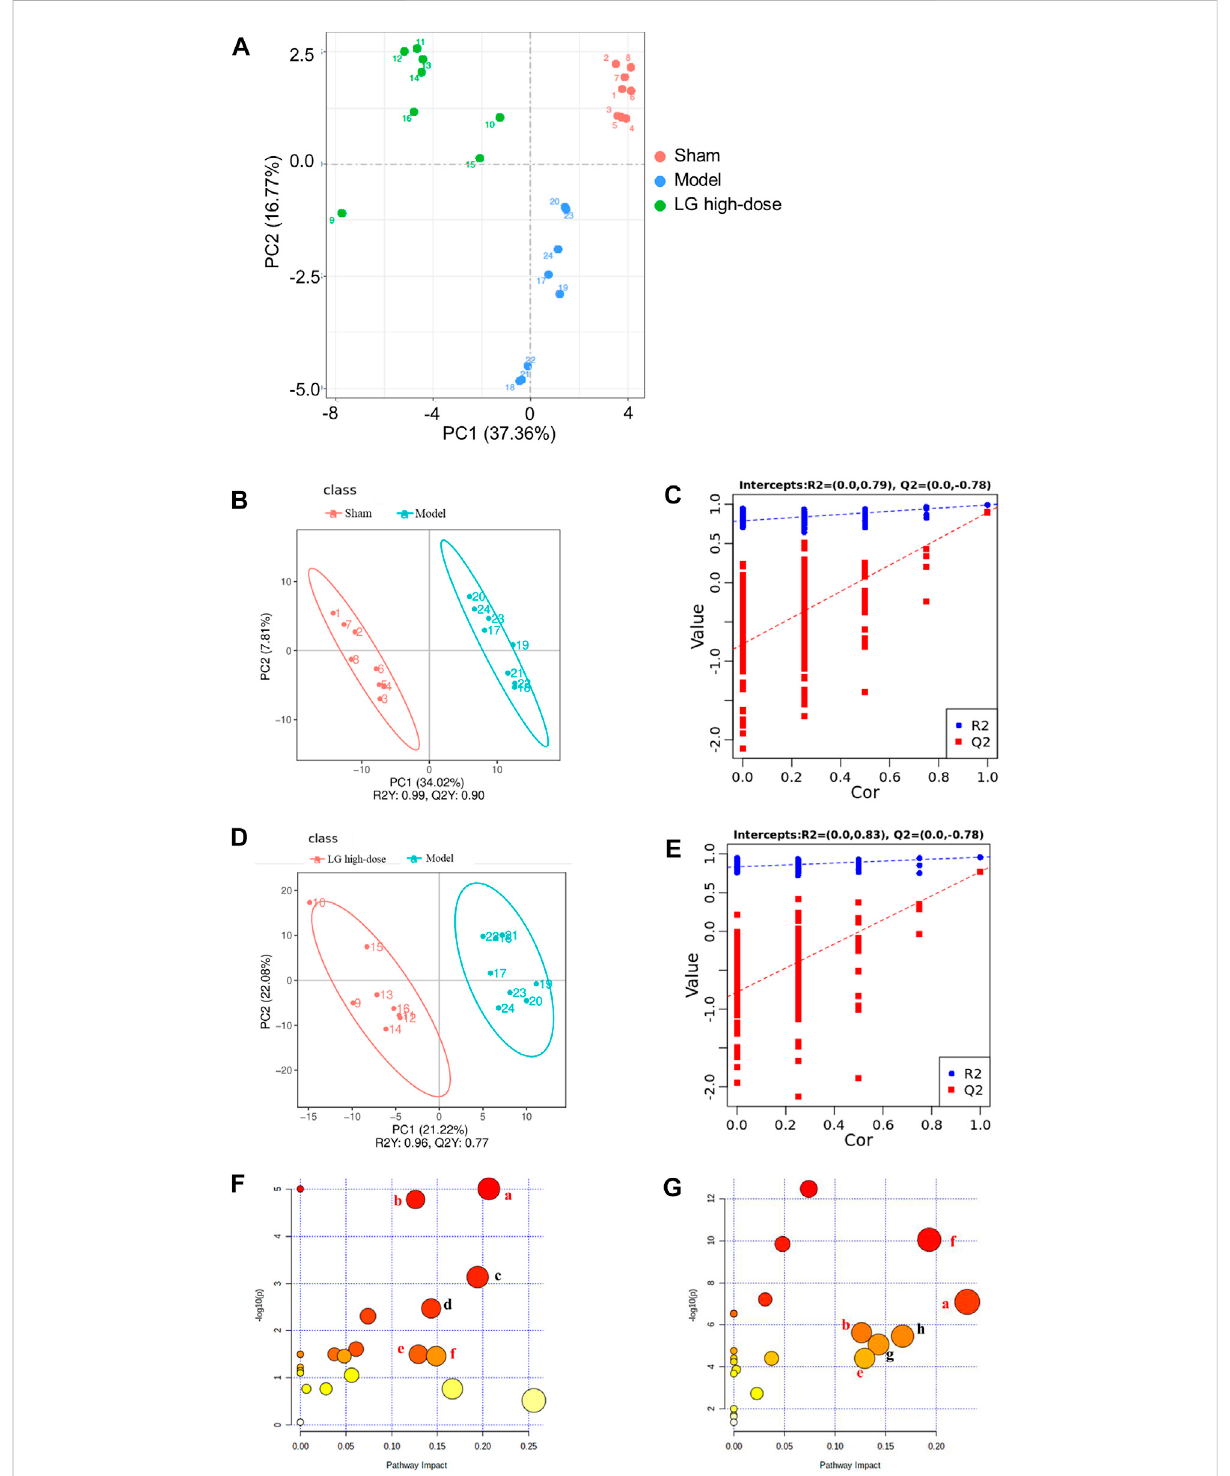
FIGURE 4 LG treatment modulated the metabolites in lung in sepsis-associated lung injury model rats. (A) Scores plots of PCA among each group. (B,C) Scores plots of PLS-DA between the sham and model groups and the corresponding coef fi cient of loading plots. (D,E) Scores plots of PLS-DA between themodel and LGhigh-dosegroups and the corresponding coef fi cient of loading plots. (F,G) Summaryof pathway analysis betweensham and model groups (F) and between model and LG high-dose groups (G) , the common pathways have been marked in red. (A) Glycine, serine and threonine metabolism; (B) Cysteine and methionine metabolism; (C) Nicotinate and nicotinamide metabolism; (D) Pyrimidine metabolism; (E) Inositol phosphate metabolism; (F) Citrate cycle (TCA cycle); (G) Tryptophan metabolism; (H) Aminoacyl-tRNA biosynthesis. Sham, model, and LG high-dose groups (n = 8 per group). PCA: principle component analysis, PLS-DA: partial least-squares discriminant